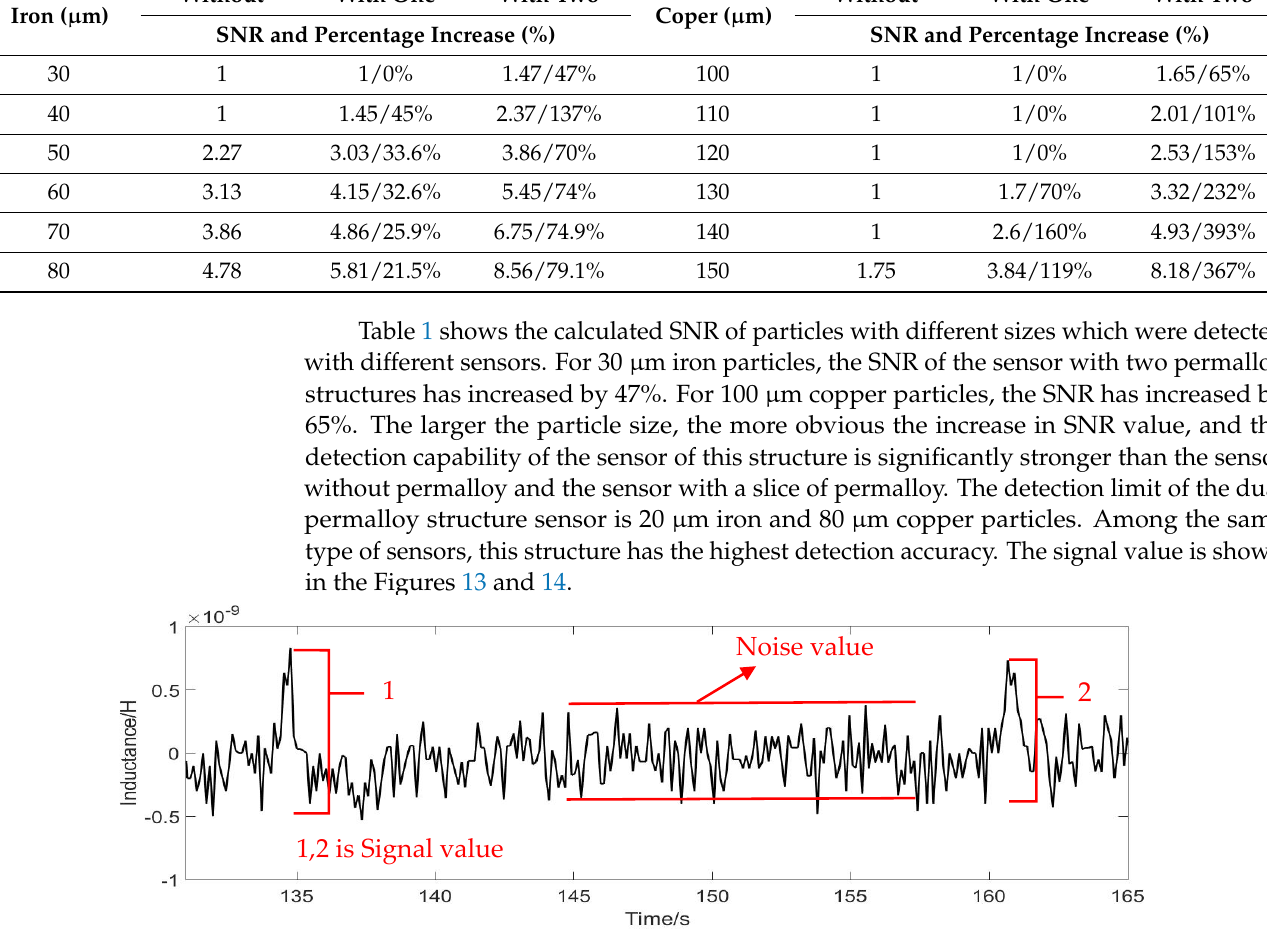
Table 1. SNR and added value in different sensors.